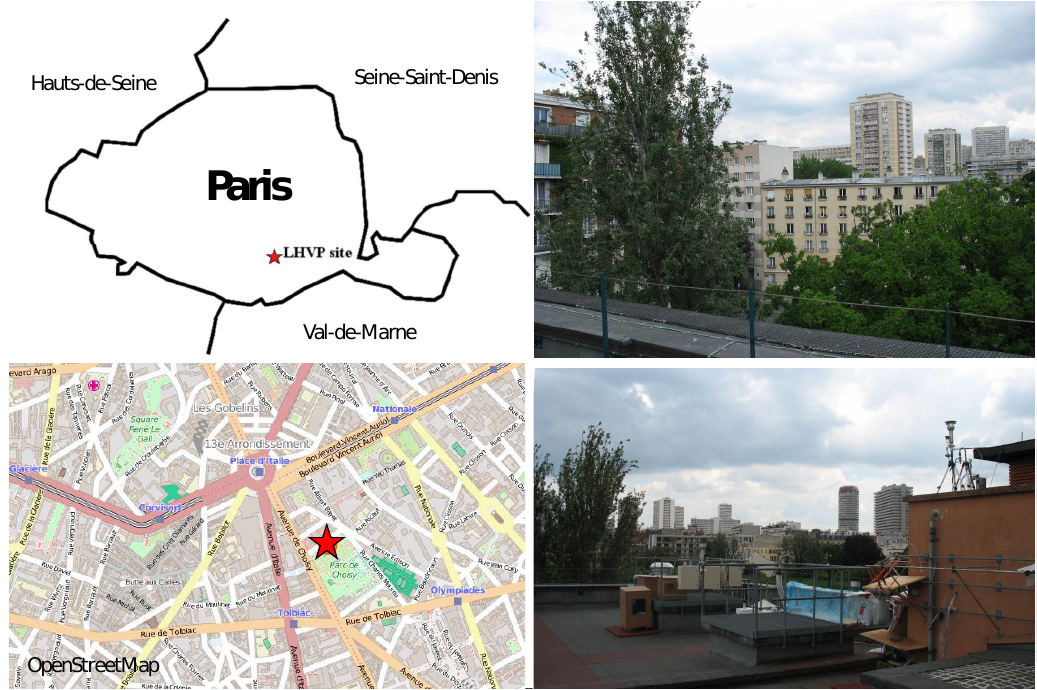
Figure 1. Location of the LHVP site in Paris (on the rooftop of Laboratoire d’Hygiène de la Ville de Paris, Paris 13 arrondissement, 11 Rue George Eastman, 75013